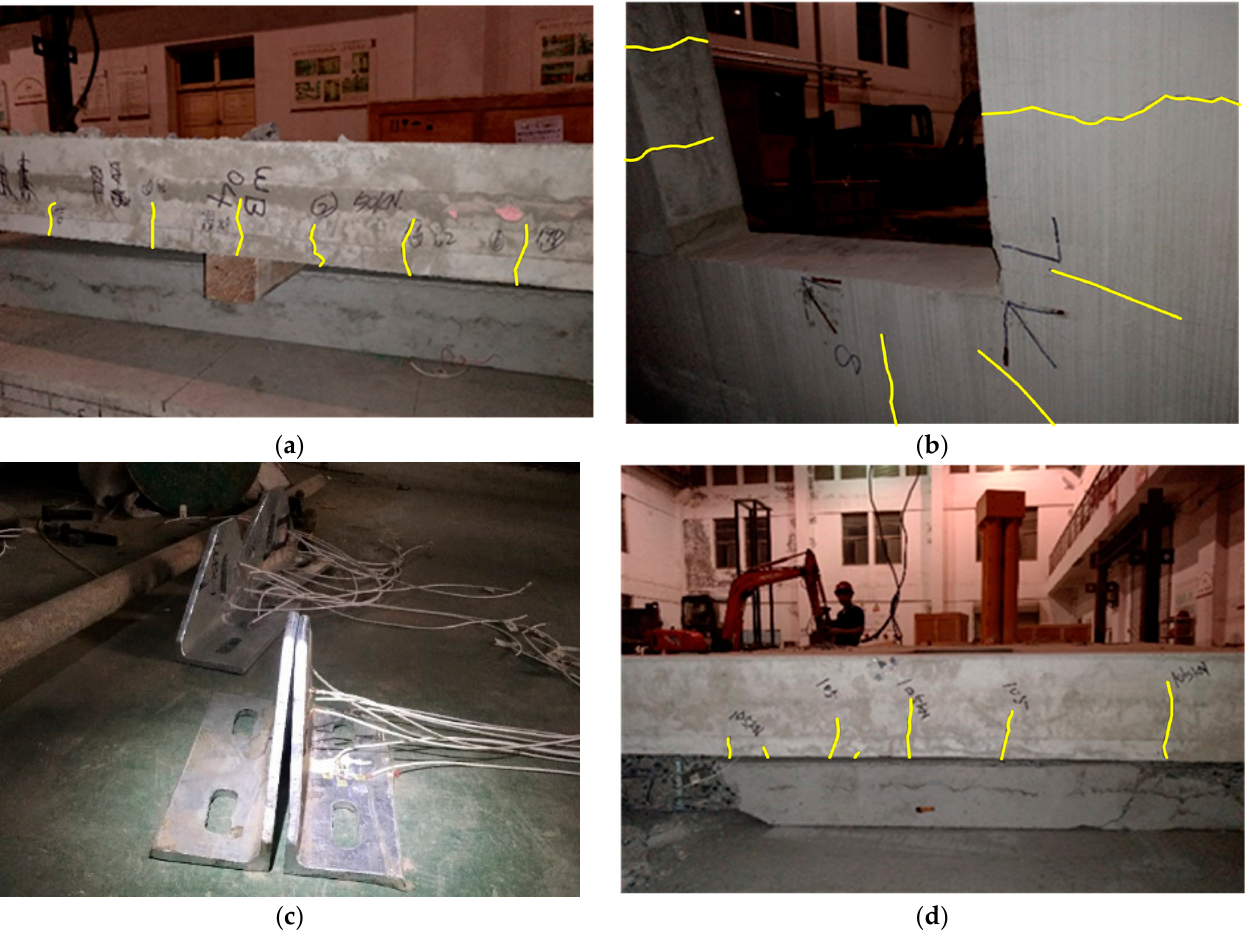
Figure 6. Typical failure modes of specimen WPO. ( a ) Cracks at a load of 50 kN. ( b ) Cracks around the opening. ( c ) Deformation of the connection angle. ( d ) Residual deformation after the loading.